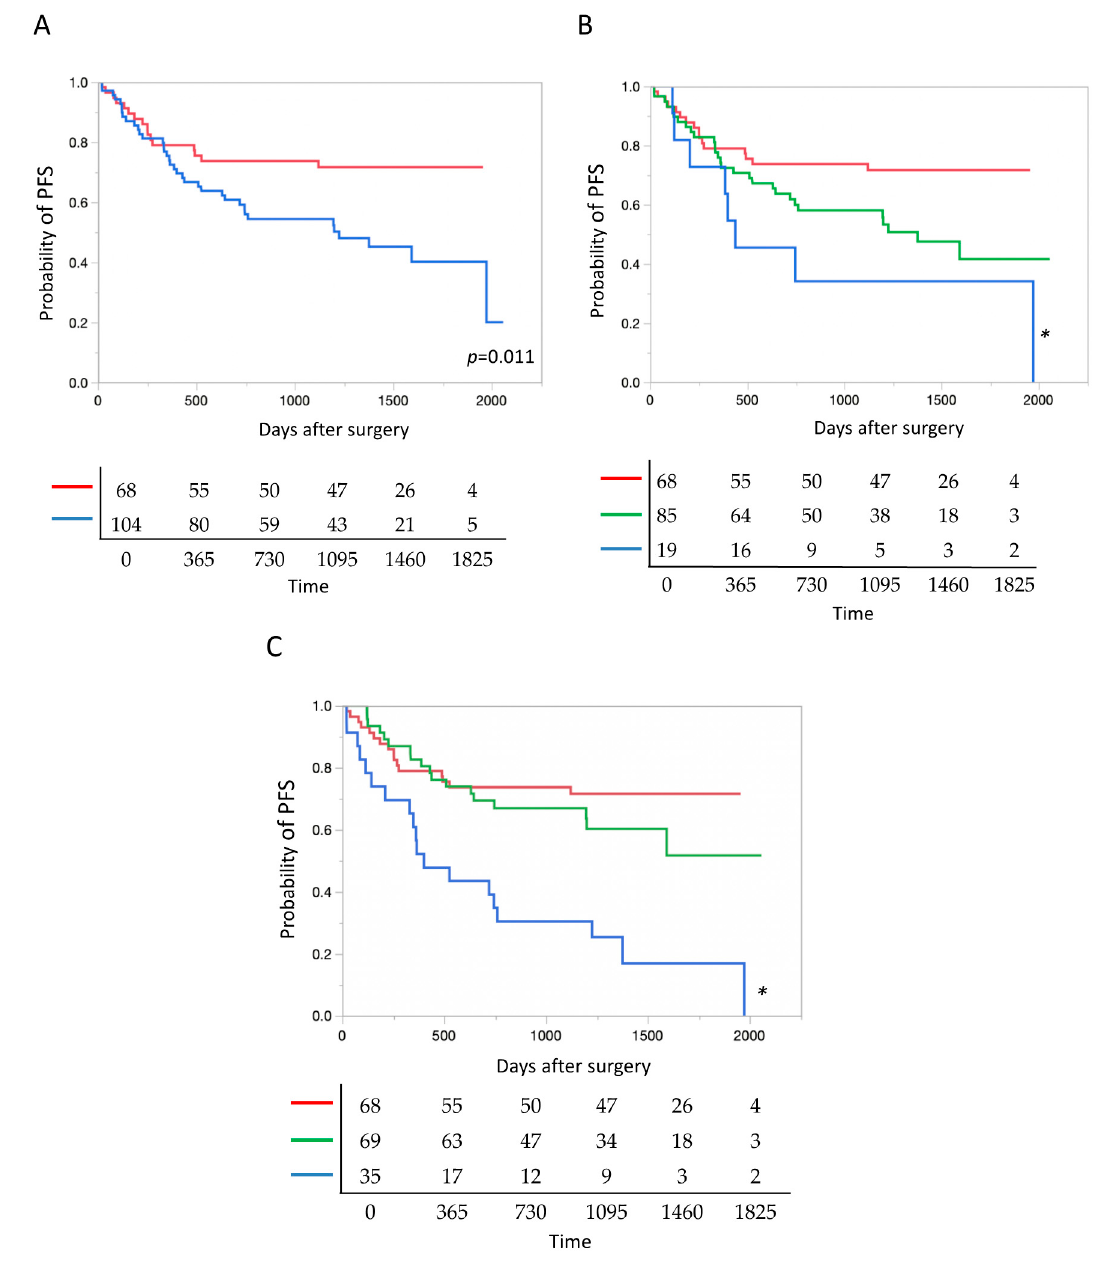
Figure 4. TP53 mutation as a prognostic factor after surgery. ( A ) Postoperative prognosis was significantly poorer in lung cancer with tumor protein p53 ( TP53 ) mutations than in lung cancer without TP53 mutations. Blue and red lines denote cancers with, and without TP53 mutations ( n = 104 and 68), respectively. ( B ) The prognosis deteriorated significantly as the number of TP53 mutations increased, i.e., in the ascending order of tumors with 0, 1, and 2 or more mutations. Red, green and blue lines denote cancers with 0, 1, and 2 or more mutations ( n = 68, 85 and 19), respectively. * p = 0.014. ( C ) According to allele fractions (AFs) of TP53 mutations, the prognosis of lung cancer was significantly poorer in the AF > 60 group than in the other two groups with AF = 0 and 0 < AF < 60. Blue, green and red lines denote cancers with the AF > 60, 0 < AF < 60, and AF = 0 ( n = 35, 69 and 68), respectively. * p < 0.0001.